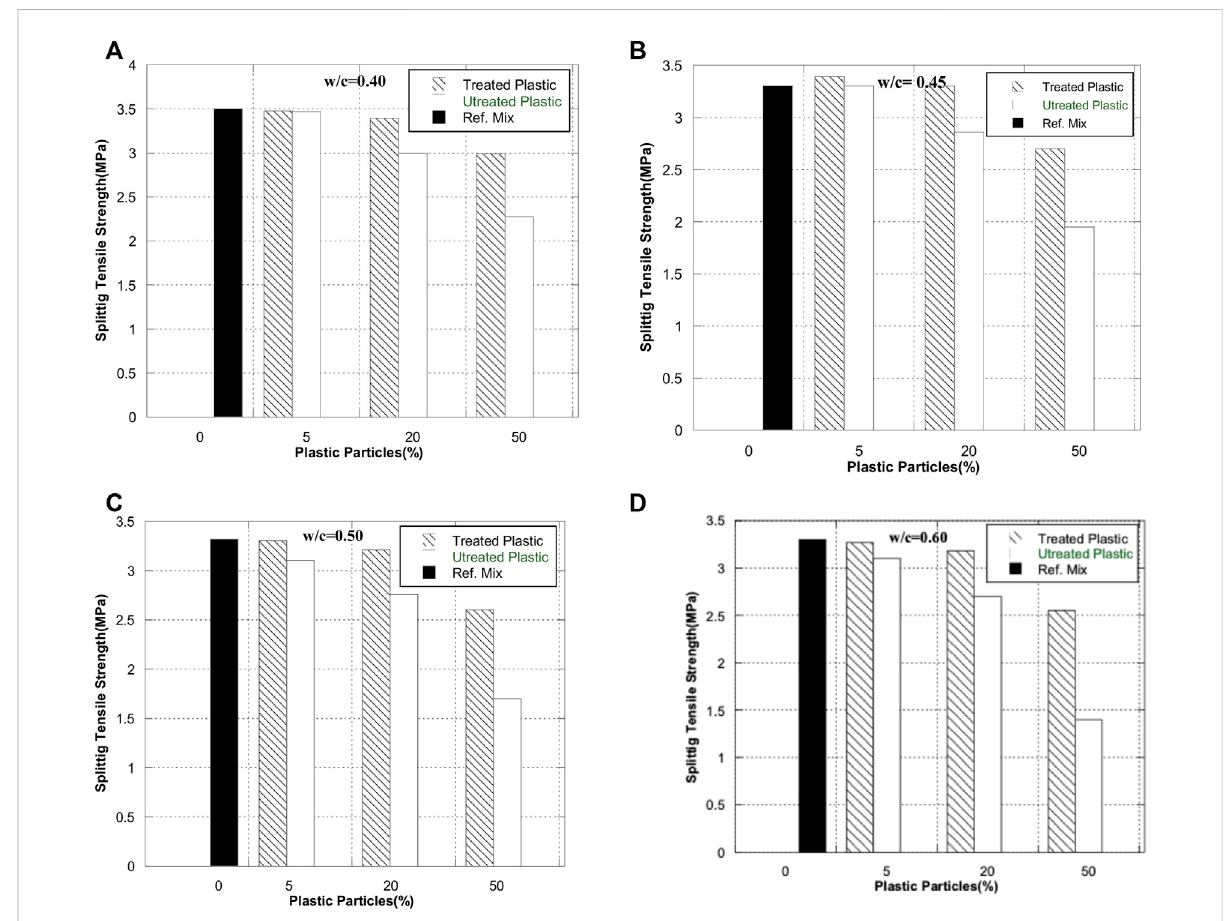
FIGURE 6 Splitting Tensile Strength for different mixes (A) w/c = 0.40, (B) w/c = 0.45, (C) w/c = 0.50, and (D) w/c =